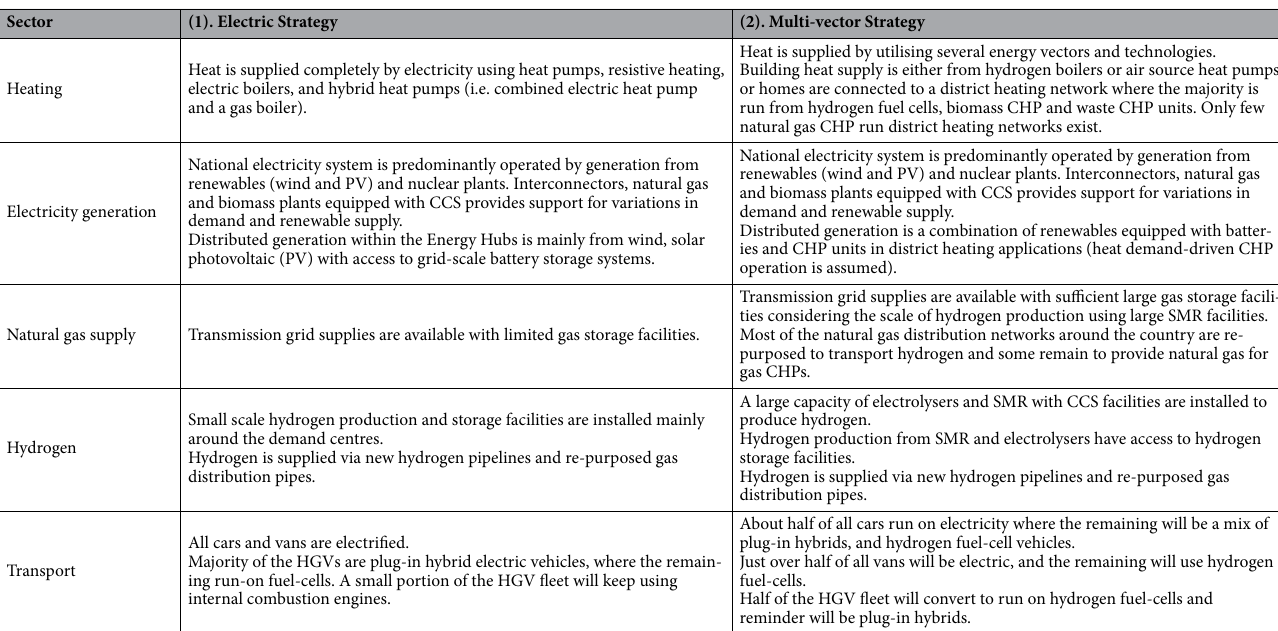
Table 1. Summary of assumptions for the Electric and Multi-vector